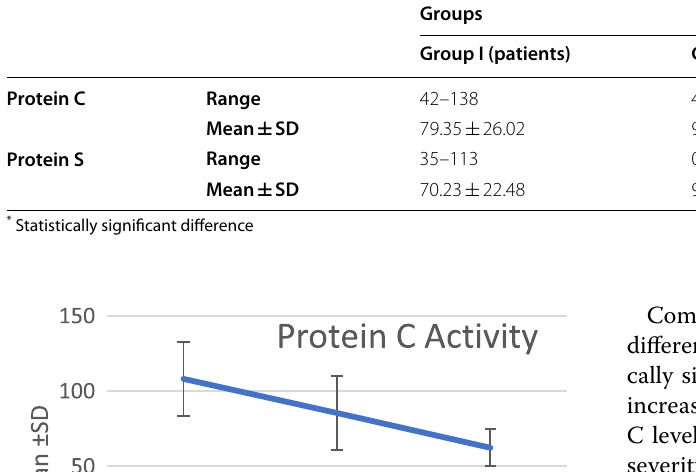
Table 3 Protein C and S activity in different COVID‑19 severity cases